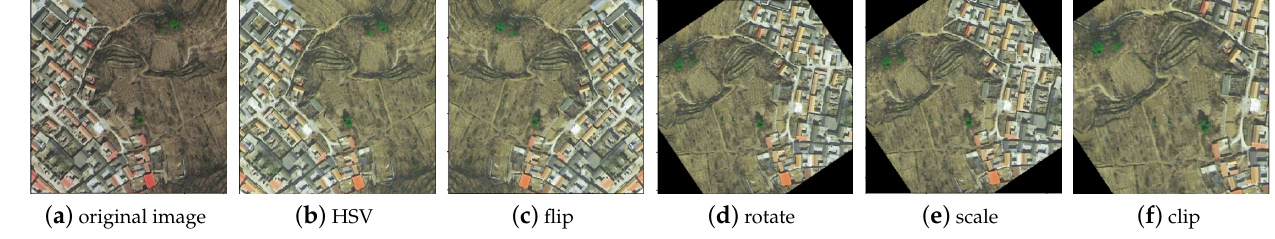
Figure 4. Sample segmentation results.